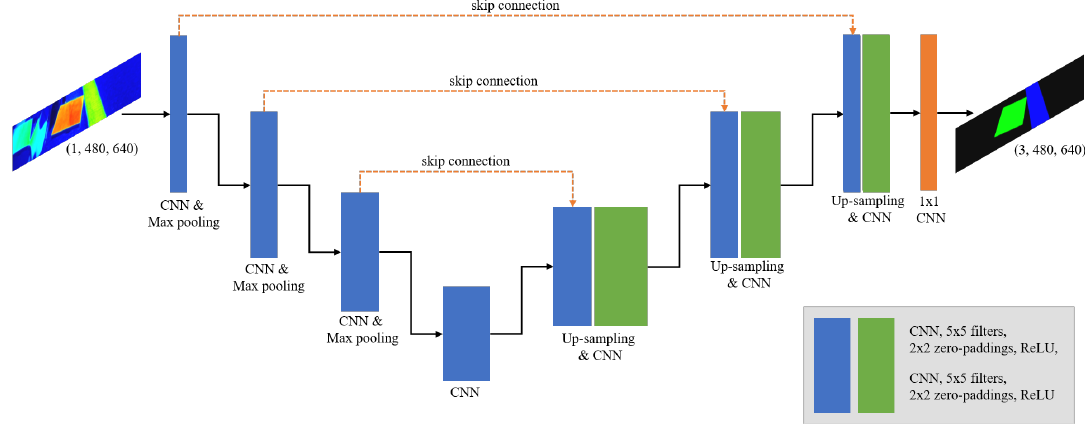
Figure 8. Architecture of segmentation CNN model.